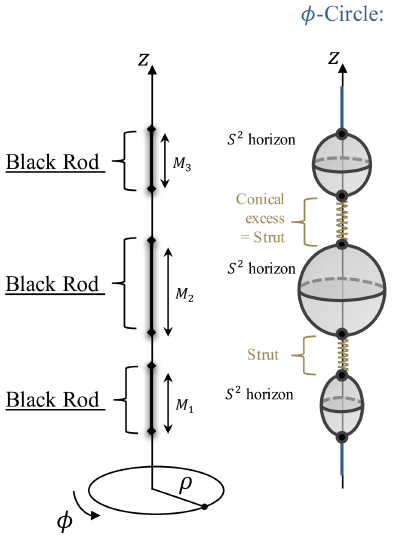
Figure 5 . Description of a chain of static four-charge non-extremal black holes in the four- dimensional framework (4.2) and the behavior of the φ -circle on the z